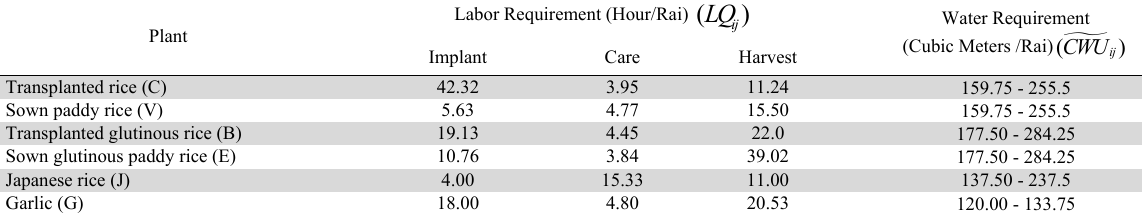
Source: From the field survey and